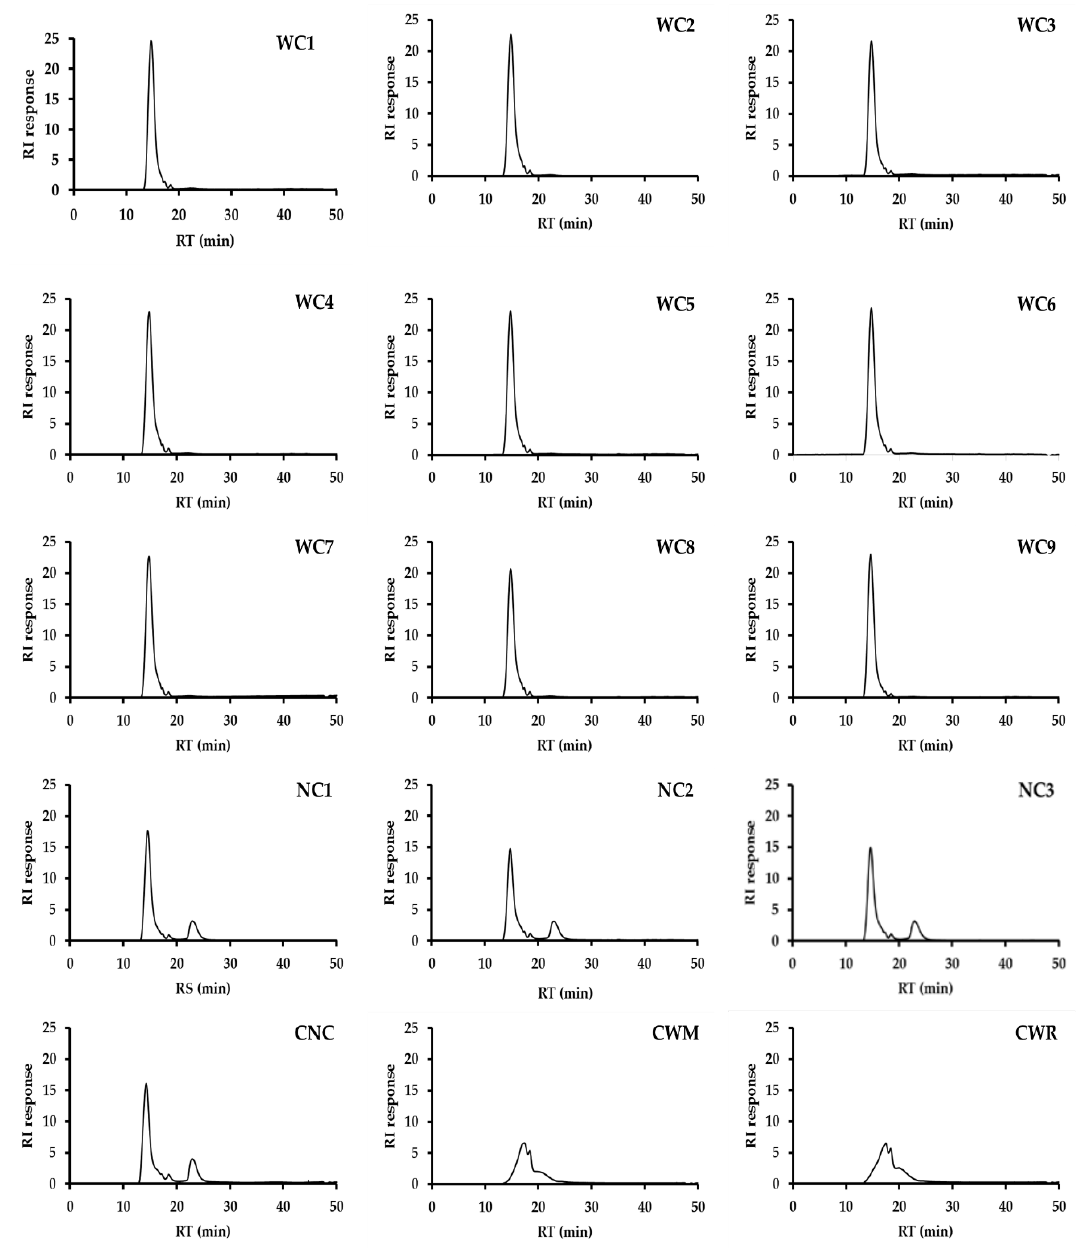
Figure 1. Chromatograms of nine Thai non-GM bred waxy cassava starches (WC1–WC9), three wild-type normal cassava starches (NC1–NC3), commercial normal cassava starch (CNC), commercial waxy maize starch (CWM) and commercial waxy rice starch (CWR) analyzed by high performance size exclusion chromatography (HPSEC).